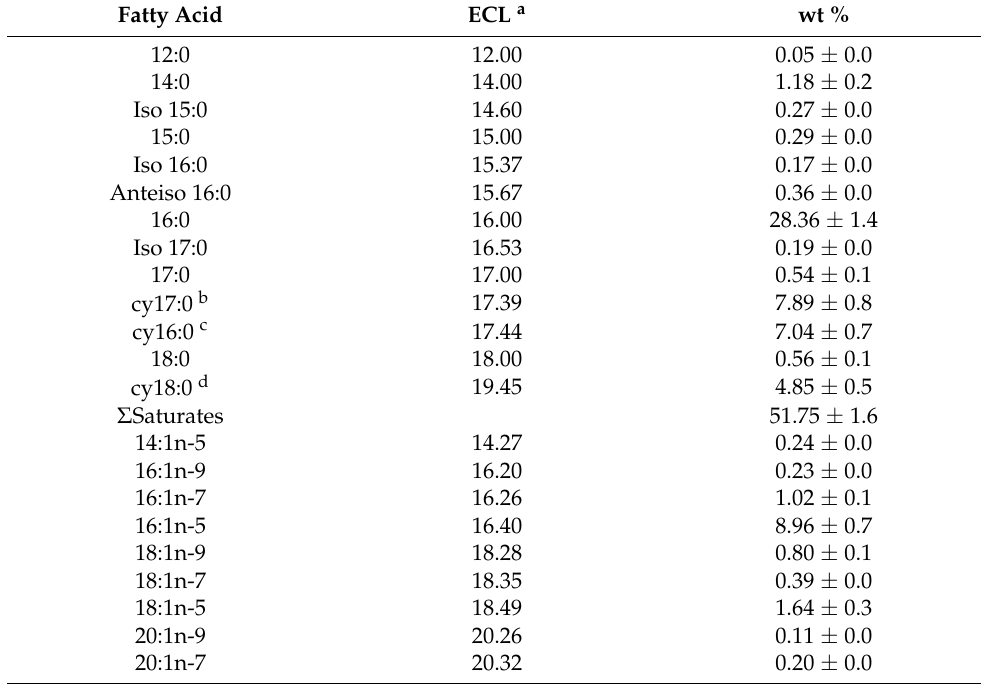
Table 1. Fatty acid composition of total lipids from Solieria pacifica